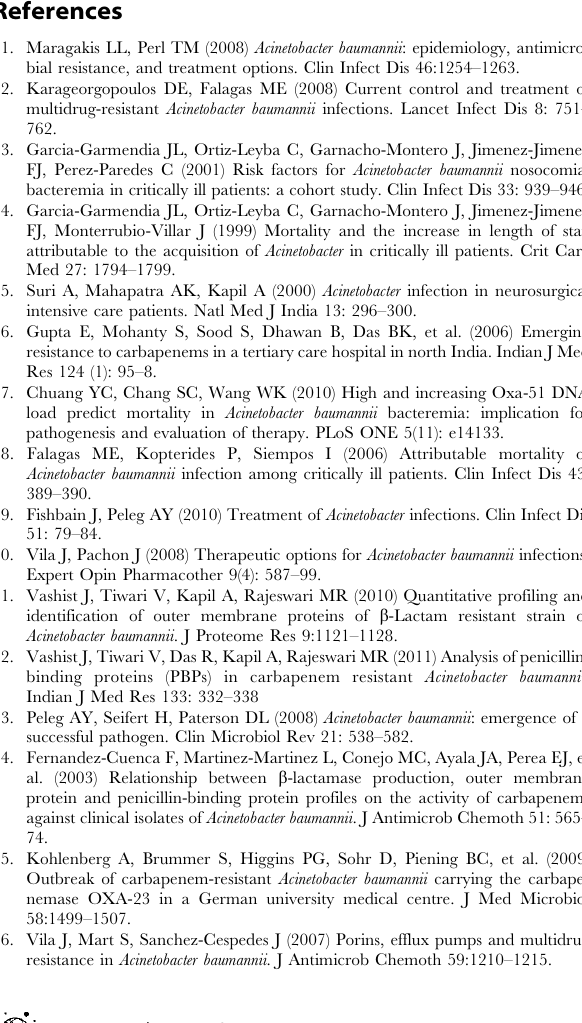
Figure S1 Differential In-Gel Electrophoresis (DIGE) results of RS307 and ATCC19606. Figure S2 DeCyder analysis of RS307 DIGE results. Figure S3 Progenesis analysis of RS307 DIGE results. Figure S4 Mascot search results for differentially expressed proteins in inner membrane fraction of RS307. (PDF) Table S1 Differentially expressed proteins identified in inner membrane fraction of RS122. Table S2 Differentially expressed proteins identified in inner membrane fraction of